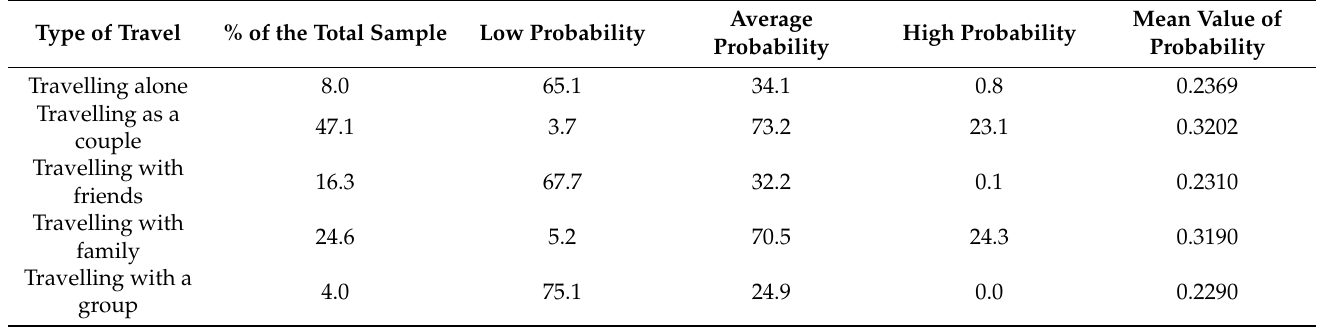
Table 5. Relationship between the type of travel and the estimated probability of visiting the Monfragüe BR.